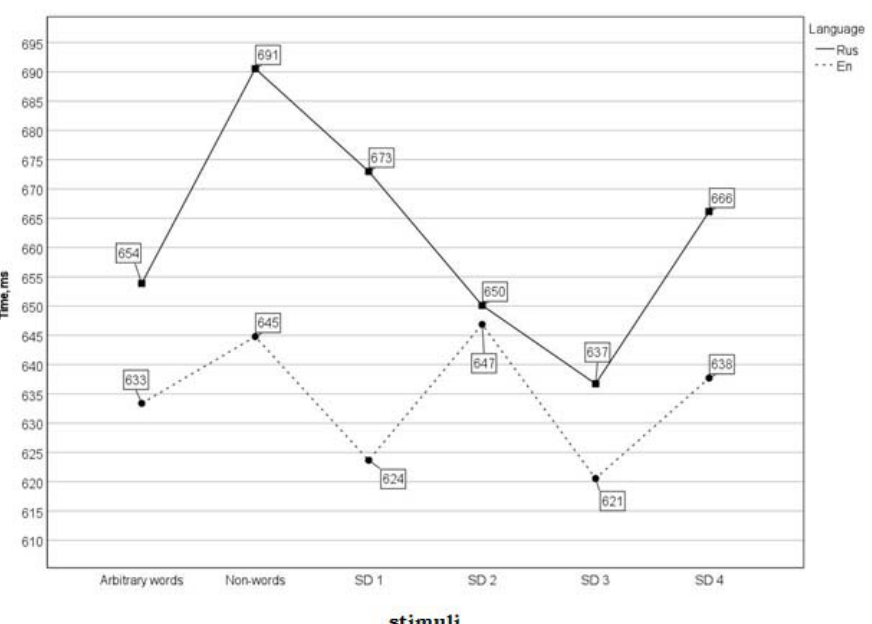
Figure 2. Word recognition time (in ms) depending on the type of the stimuli in Russian and English. Figures 3 and 4 below show the average reaction time (in ms) of word recognition with a demonstration of the statistical significance for Russian and English stimuli, re ‐ spectively.